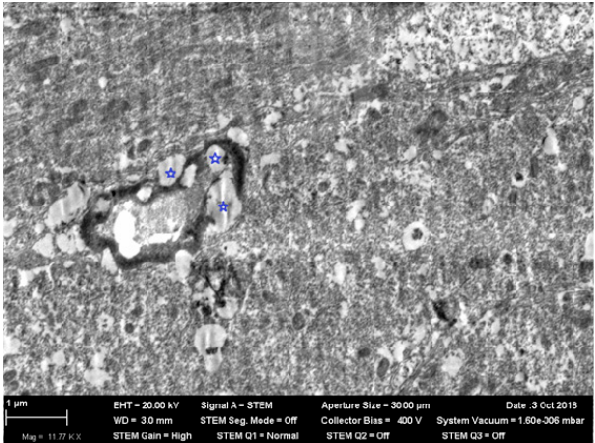
Figure 2. Autolysis in the body of a neuron in an olfactory bulb of rat brain after 3 months of inhalation exposure to NIO-NPs at a concentration of 0.23 mg/m 3 . STEM; magnification: 7620×.